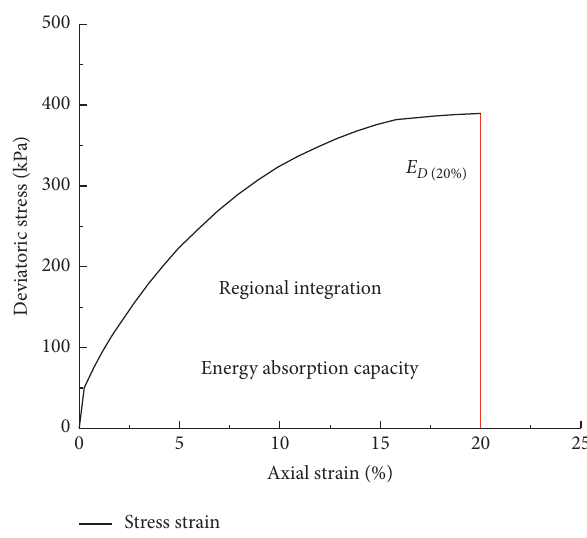
Figure 16: Energy absorption capacity calculation.